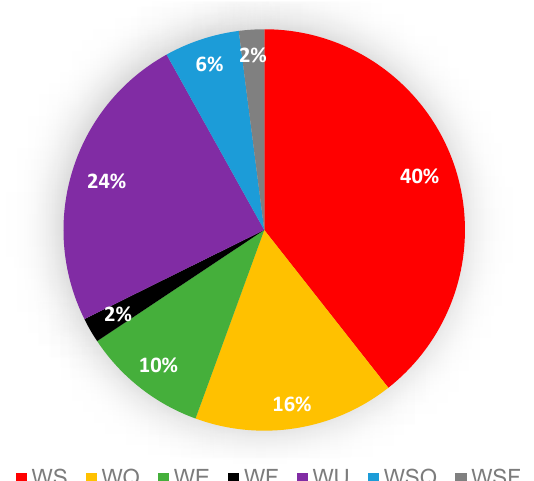
Figure 7. Distribution of publications based on water problem context-based classification. WS (water shortage), WQ (water quality), WE (water-ecosystem/environment), WF (water for flood management), WU (water use planning), WSQ (water shortage-quality), WSF (water shortage-flood management).